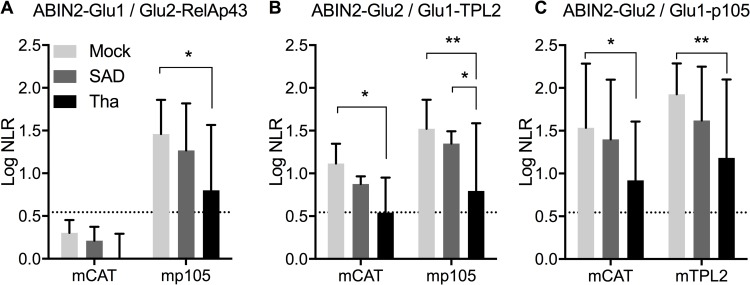
ABIN2 is excluded from a RelAp43-p105-TPL2 complex during Tha infection.Interactions between ABIN2 and RelAp43 (A), TPL2 (B) or p105 (C), using PCA technology, in combination with a third protein: mCAT, mp105 or mTPL2, and infected or not by Tha or SAD virus. HEK293T cells were infected at a MOI of 1 and transfected 3h later with 4 plasmids expressing: a Glu1-, a Glu2-, a cMyc-tagged protein and a firefly luciferase for 48h before measuring both gaussia and firefly activity. Position of the tag is indicated as follow: Glu1-, Glu2- for N-ter and -Glu1, -Glu2 for C-ter. Results are the mean of the logarithm of gaussia NLR values normalized to luciferase activity of at least 4 distinct experiments. A threshold of NLR = 3.5 previously described [54] was used to define the positive results (log 3.5 = 0.54). Error bars represent the standard deviation. **p<0.01; *p<0.05.